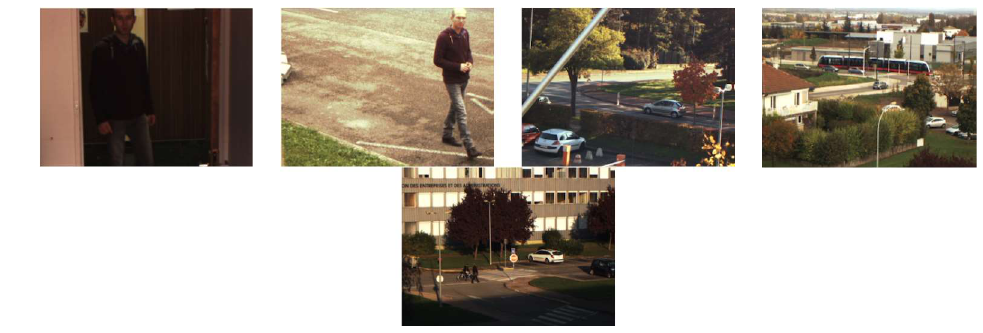
Figure 3. Examples of the dataset [20].